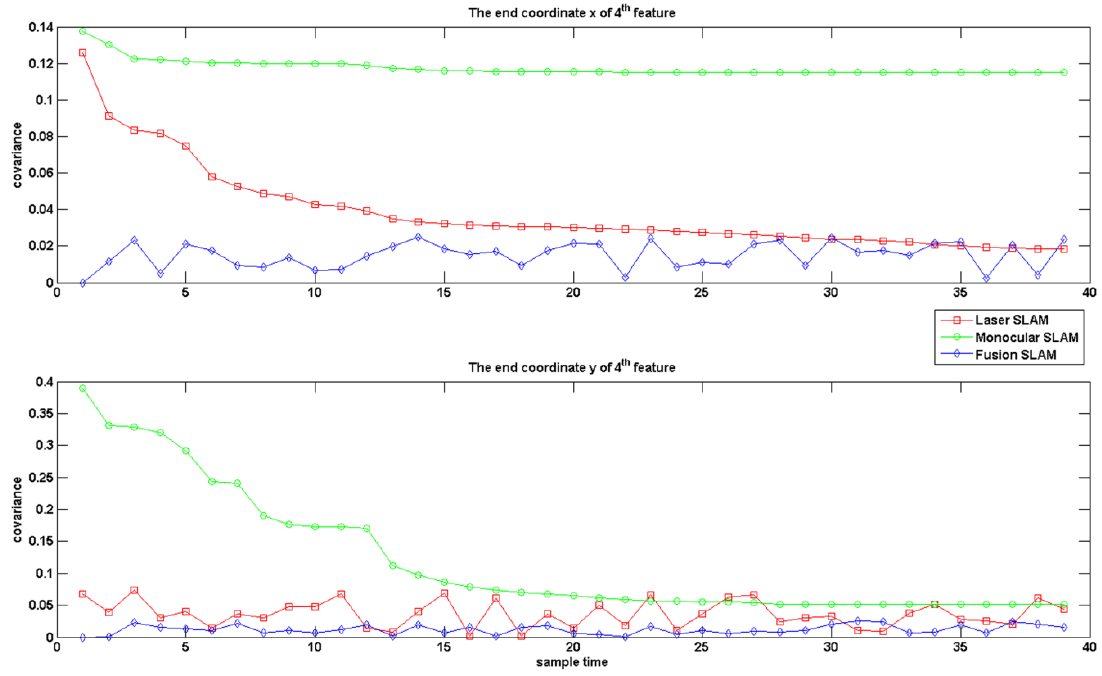
Figure 7. The estimated covariance of an endpoint of one line feature. Red line: estimated covariance in laser SLAM; Green line: estimated covariance in monocular SLAM; Blue lines: estimated covariance in